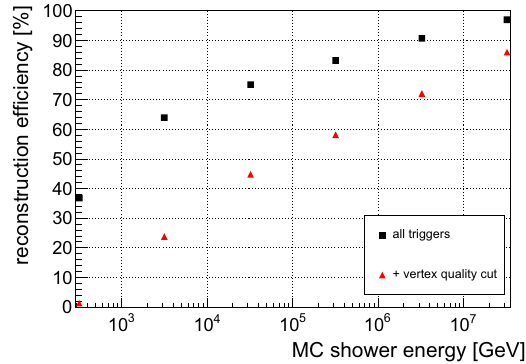
Fig. 2 Left the neutrino effective area after applying the vertex-quality cut to triggered events, and integrated over all directions, as a function of simulated neutrino energy for ν e ( black full squares ) and ν e ( red open squares ) CC events, and ν ( black triangles ) and for ν ( red open